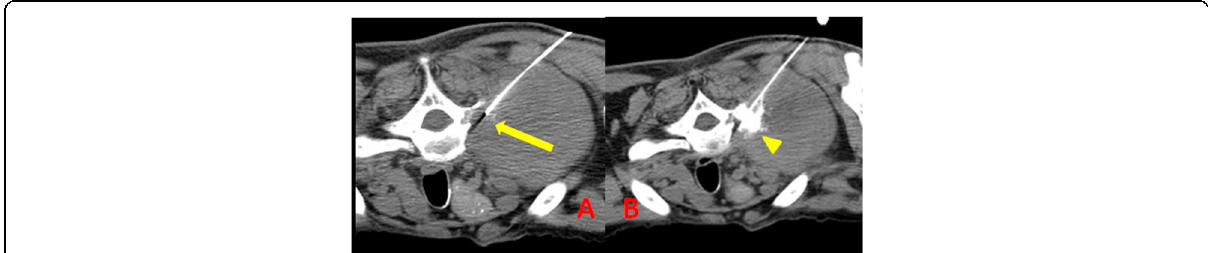
Fig. 12 Postero-lateral approach in stellate ganglion neurolysis. Axial CT section ( a ) of the pre-procedure showing the needle tip in the stellate ganglion and post-procedure ( b ) free flow of contrast (arrowhead) in the stellate ganglion